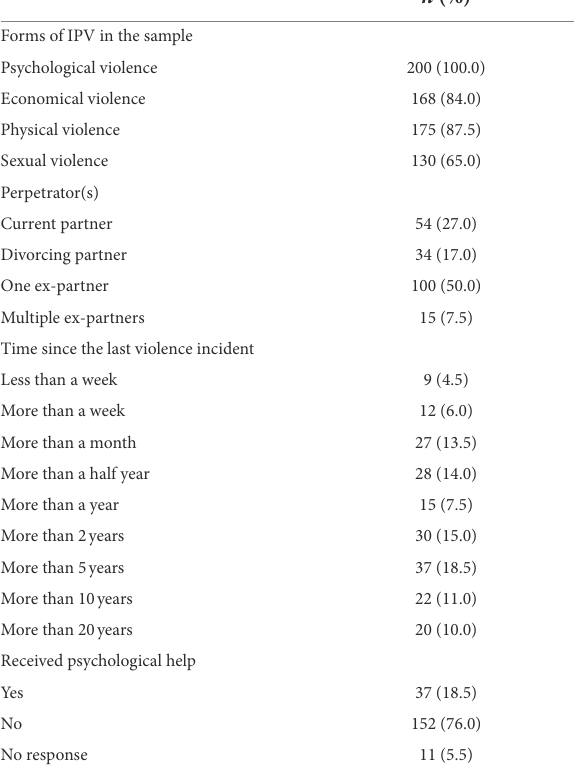
TABLE 1 IPV-related